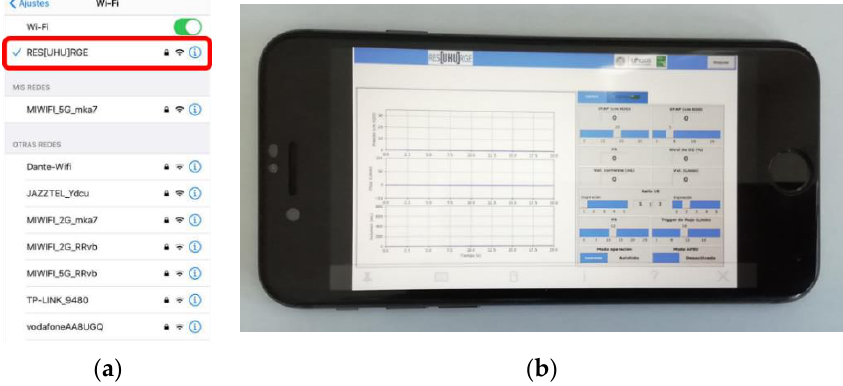
Figure 8. Remote controller of the developed ventilator. ( a ) WiFi connection point; ( b ) mobile app.